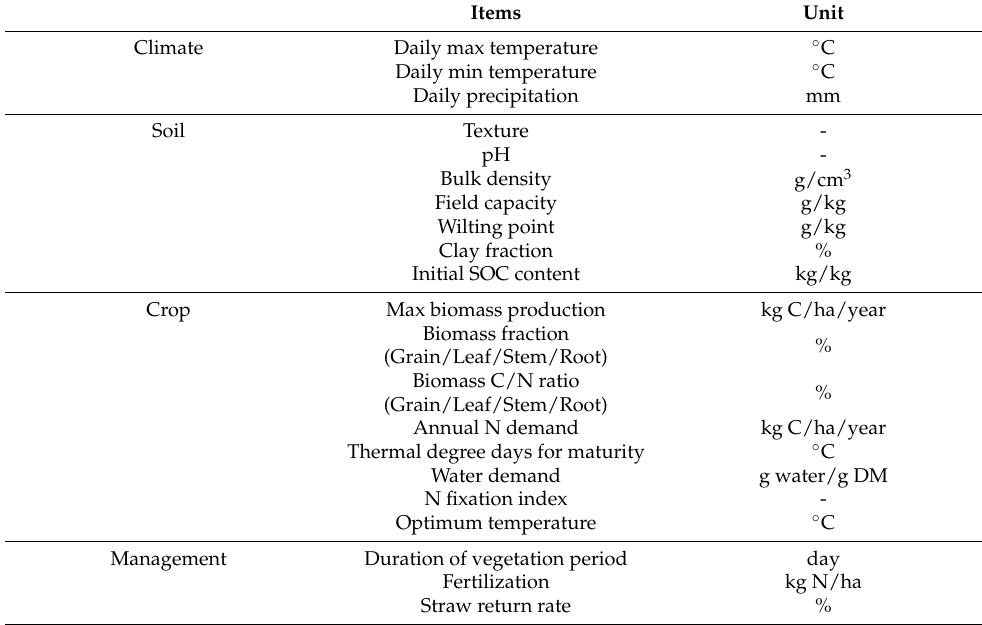
Table 1. Main input parameters for the DNDC